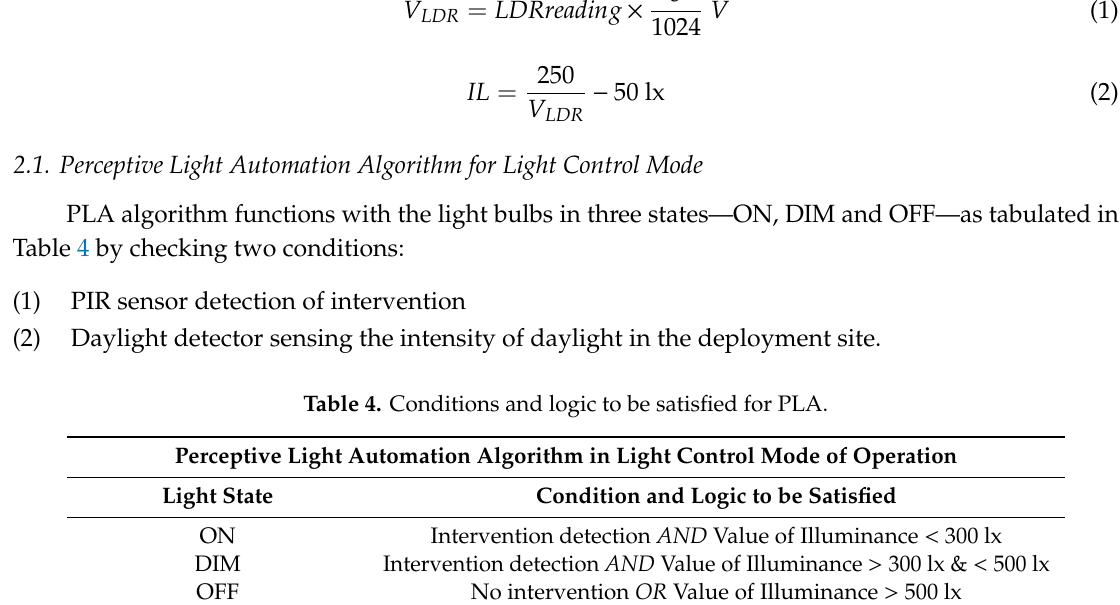
Table 4. Conditions and logic to be satisfied for